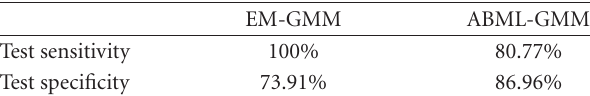
Table 4: Obtained two statistical measures for binary-classification